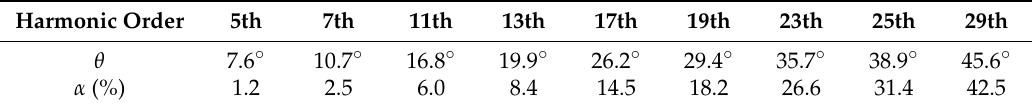
Table 2. Phase Delay and Harmonic Compensation Error.